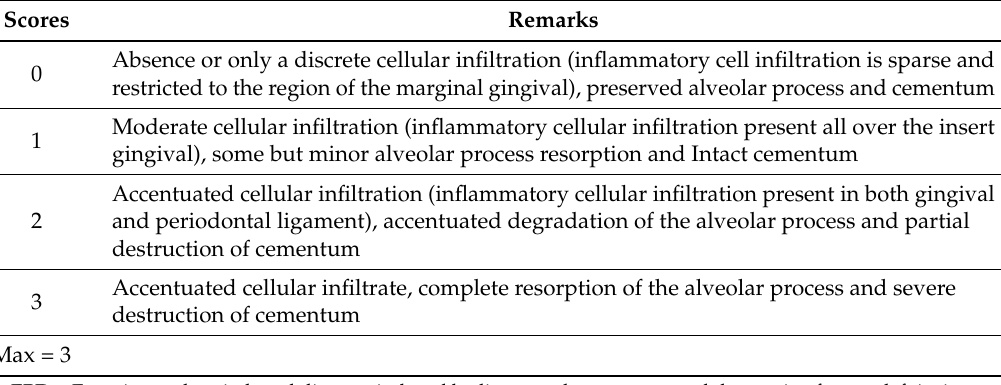
Table 3. The Histological Scores of EPD Used in This